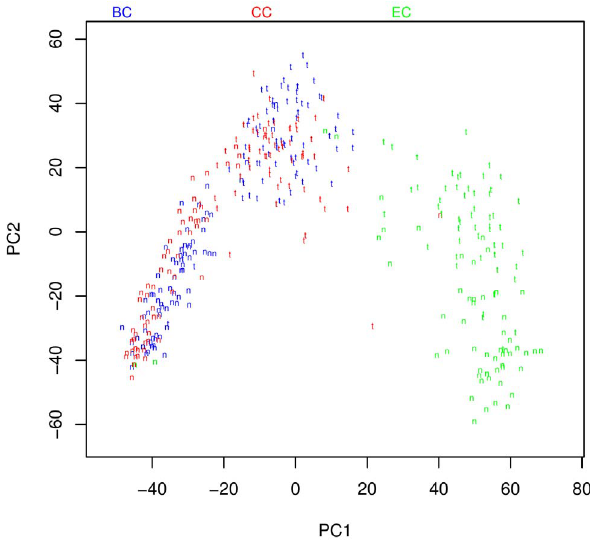
Figure 1. Principle component analyses of RNA expression for gastric cardia, gastric noncardia, and esophageal cancers. PCA revealed two major clusters of samples separating gastric cancer (CC [GCA] in red, N=62; BC [GNCA] in blue, N=72) from EC [ESCC] (green, N=53) in the PC1 axis. PC2 further divided clusters into tumor (t) and normal (n) samples. (Note regarding comparability of expression results: Cases of ESCC, GCA, and GNCA were enrolled concurrently from a single hospital using a common protocol; samples were collected, processed, stored, and transported in an identical manner; and laboratory analyses were performed during the same time period, in the same lab, by the same technical staff, using the same platform, and the same technical approach.).